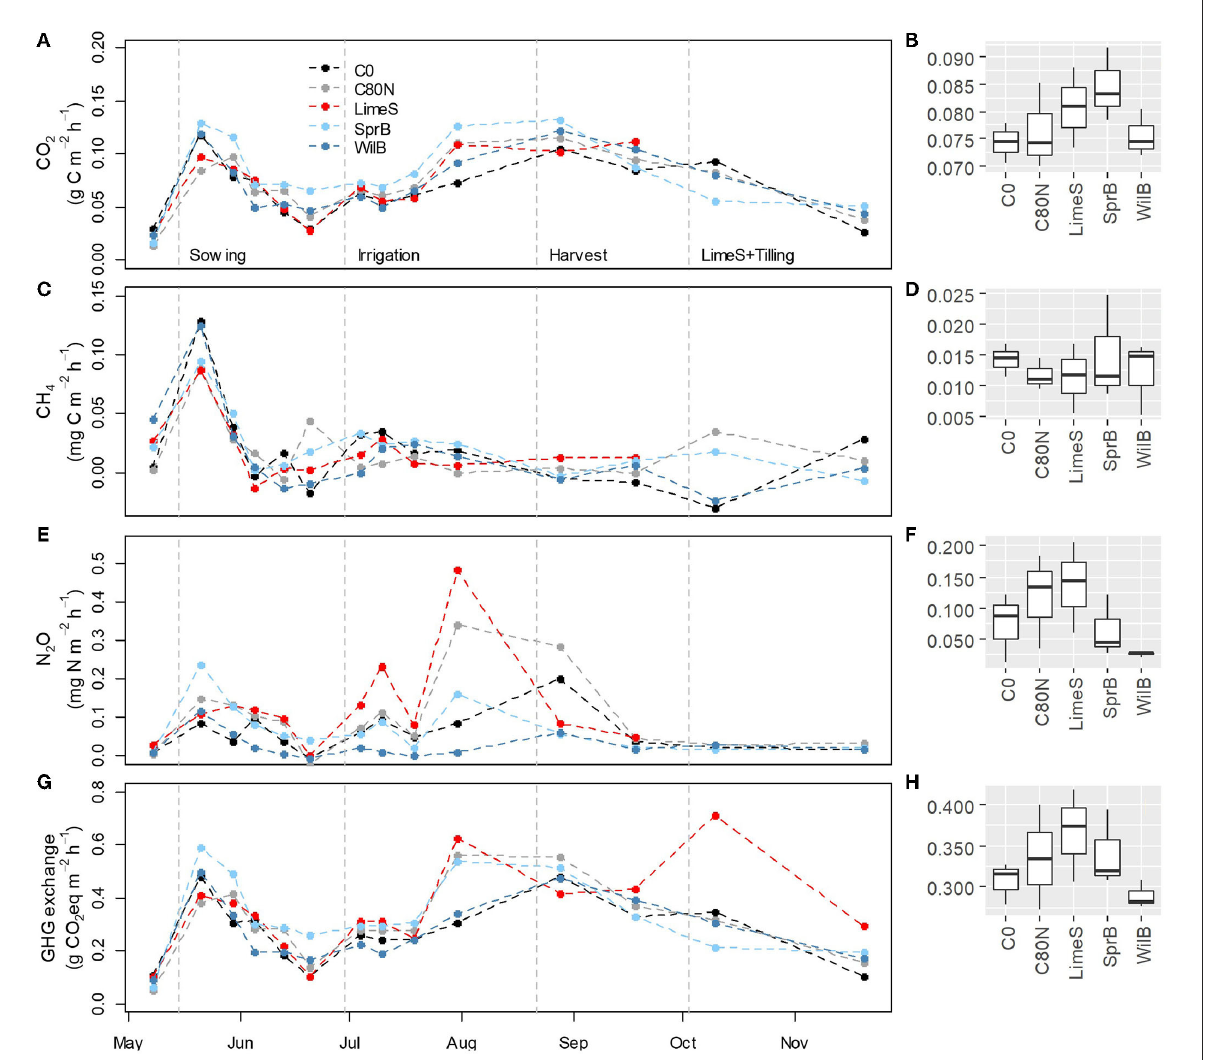
FIGURE7 Left: Mean heterotrophic flux (F H ) for carbon dioxide (CO 2 ) (A) , methane (CH 4 ) (C) , nitrous oxide (N 2 O) (E) and all greenhouse gases (GHGs) as CO 2 equivalents (G) in the different treatment plots measured from bare soil through the measurement campaign. Right: Mean F H of CO 2 (B) , CH 4 (D) , N 2 O (F) and GHG exchange (H) in the different treatment plots in May–September. Note the varying scale on the y-axis. Units in the panels on the right are the same as for the panels on the left. C0, non-fertilized control; C80N, fertilized control; LimeS, lime-stabilized pulp sludge; SprB, spruce biochar; WilB, willow